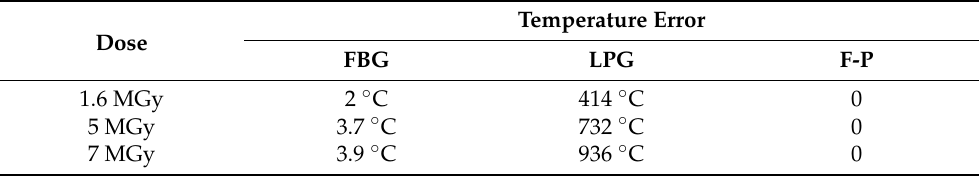
Table 5. Radiation-induced temperature errors in FBG, LPG, and F-P sensors at higher doses. Dose